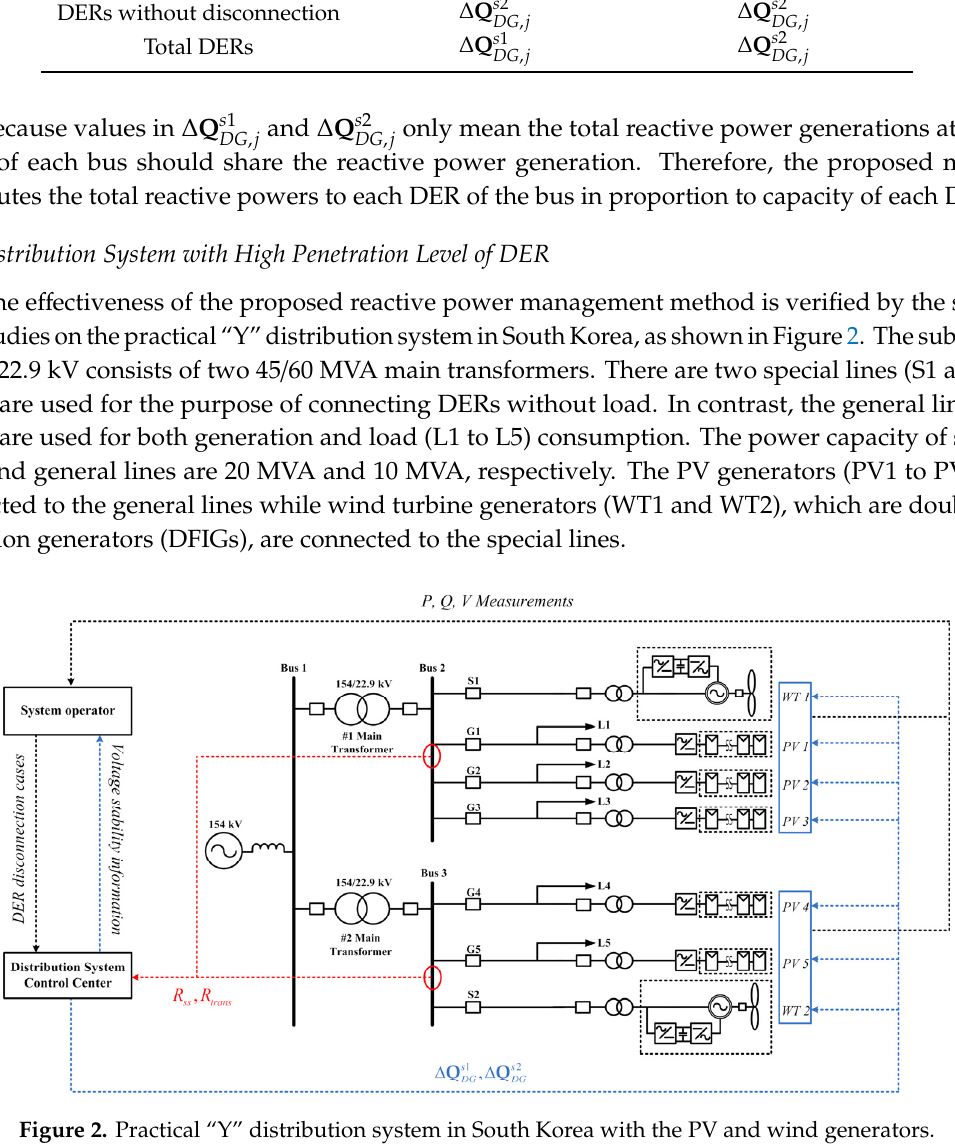
Table 2. Generations, system parameters, and load of “Y” substation.